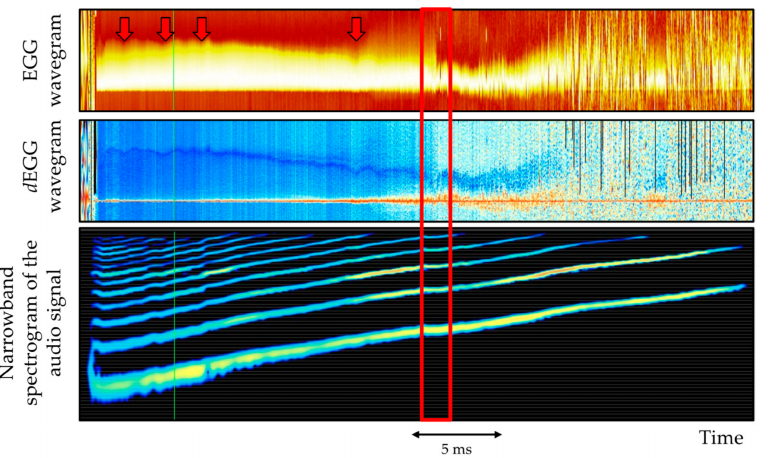
Figure 8. VoceVista Video Pro display of an ascending glissando sung by a male. Top panel: EGG wavegram. Middle panel: d EGG wavegram. Bottom panel: narrow band spectrogram. Red box highlights a voice break and the red arrow highlights f o